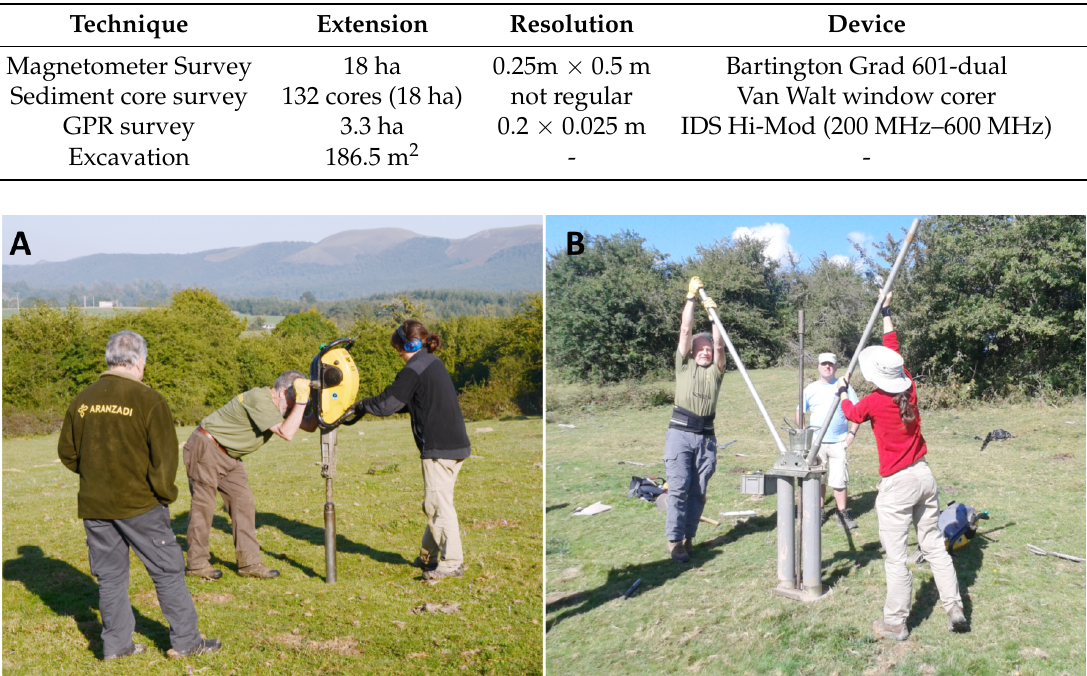
Table 1. Applied survey techniques.